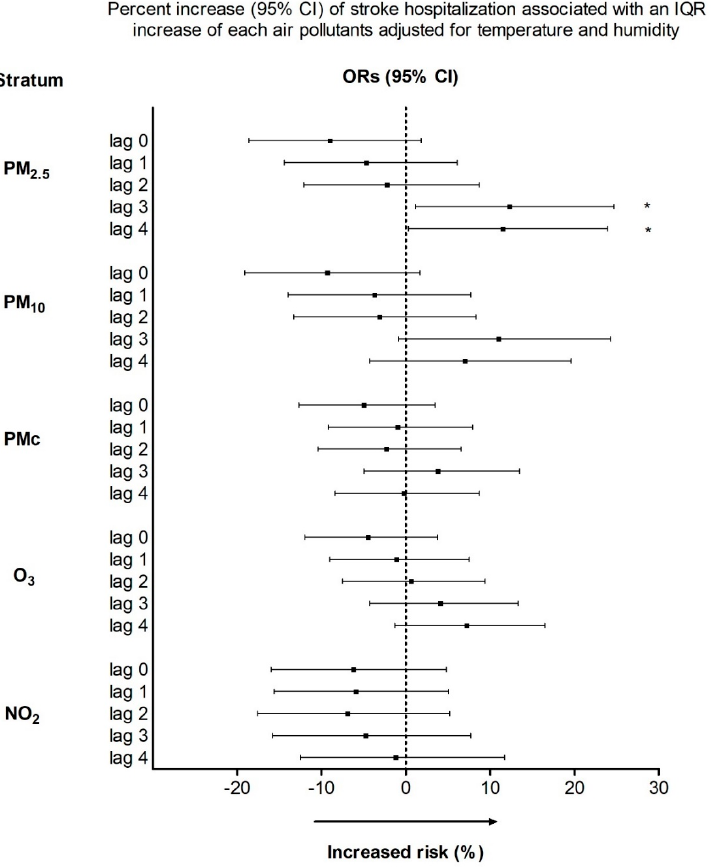
Figure 1. Odds ratios (ORs) and 95% confidence intervals (CIs) for stroke hospitalization associated with IQR increments in each air pollutant.